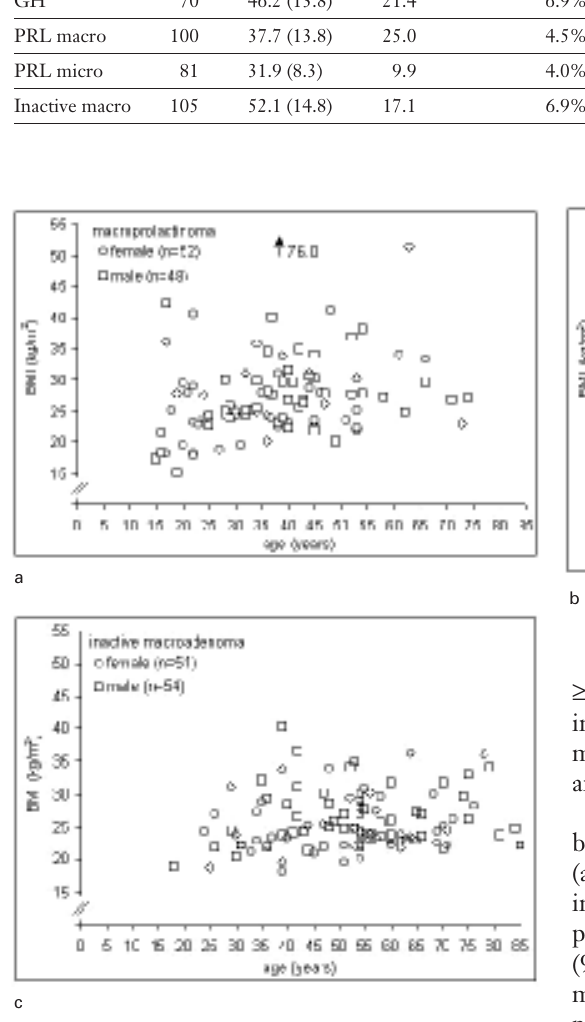
Table 3 Obesity in patients with pituitary tumour and in the general population stratified by age group (%).